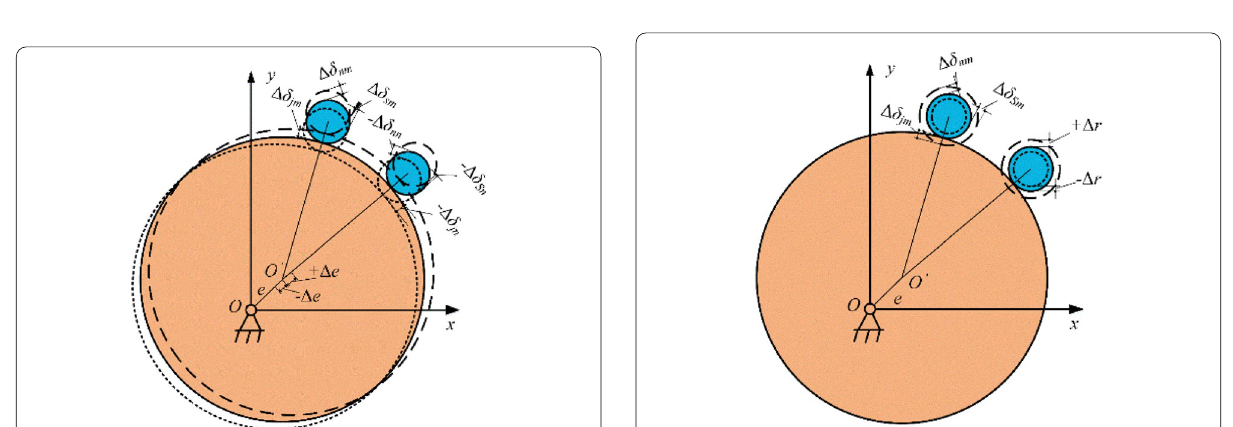
Figure 8 Distortion with installation error of disk cam Figure 9 Distortion with manufacturing error of movable